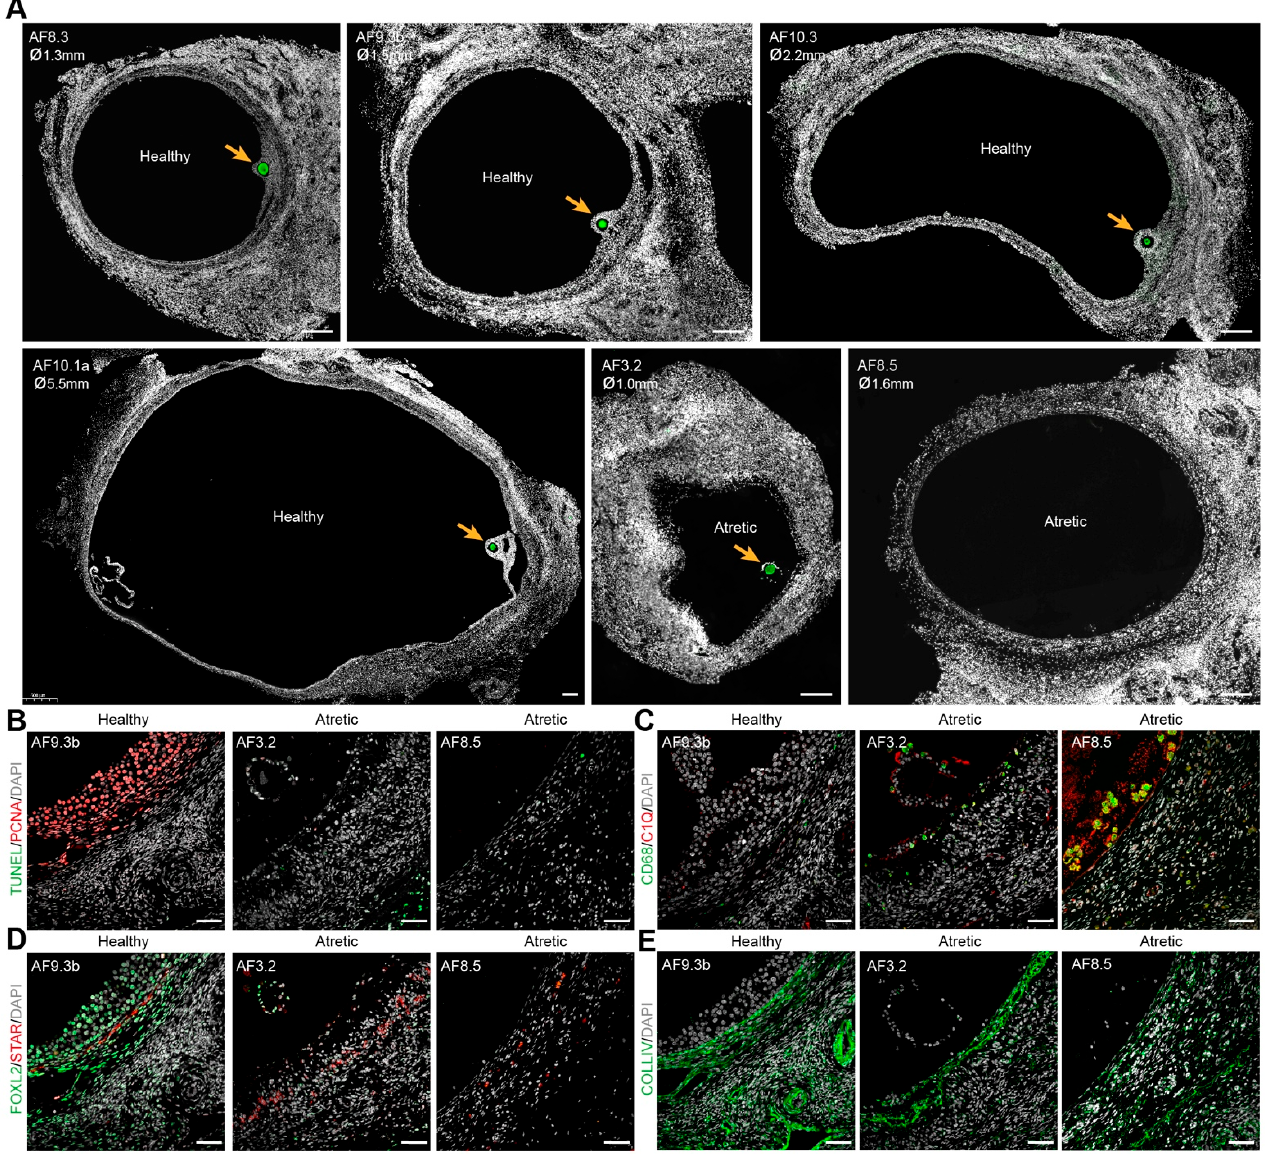
Figure 1. Morphology of healthy and atretic small antral follicles in adult ovaries. ( A ) Immunofluorescence for DDX4 (green) in healthy and atretic small antral follicles (AF). Orange arrows indicate DDX4+ oocytes. ø, follicle diameter in millimeters (mm); ( B ) Immunofluorescence for PCNA and TUNEL staining showing cell proliferation (PCNA+) and cell apoptosis (TUNEL+) in healthy and atretic follicles; ( C ) Immunofluorescence for CD68 and C1Q showing localization of macrophages (CD68+C1Q+) in healthy and atretic follicles; ( D ) Immunofluorescence for FOXL2 and STAR showing (FOXL2+) GCs, (FOXL2+) non-steroidogenic theca cells (TC) and (STAR+) steroidogenic TC in healthy and atretic follicles; ( E ) Immunofluorescence for COLIV marking the basement membrane. Scale bars in ( A ) are 200 µ m and in ( B – E ) are 50 µ m.